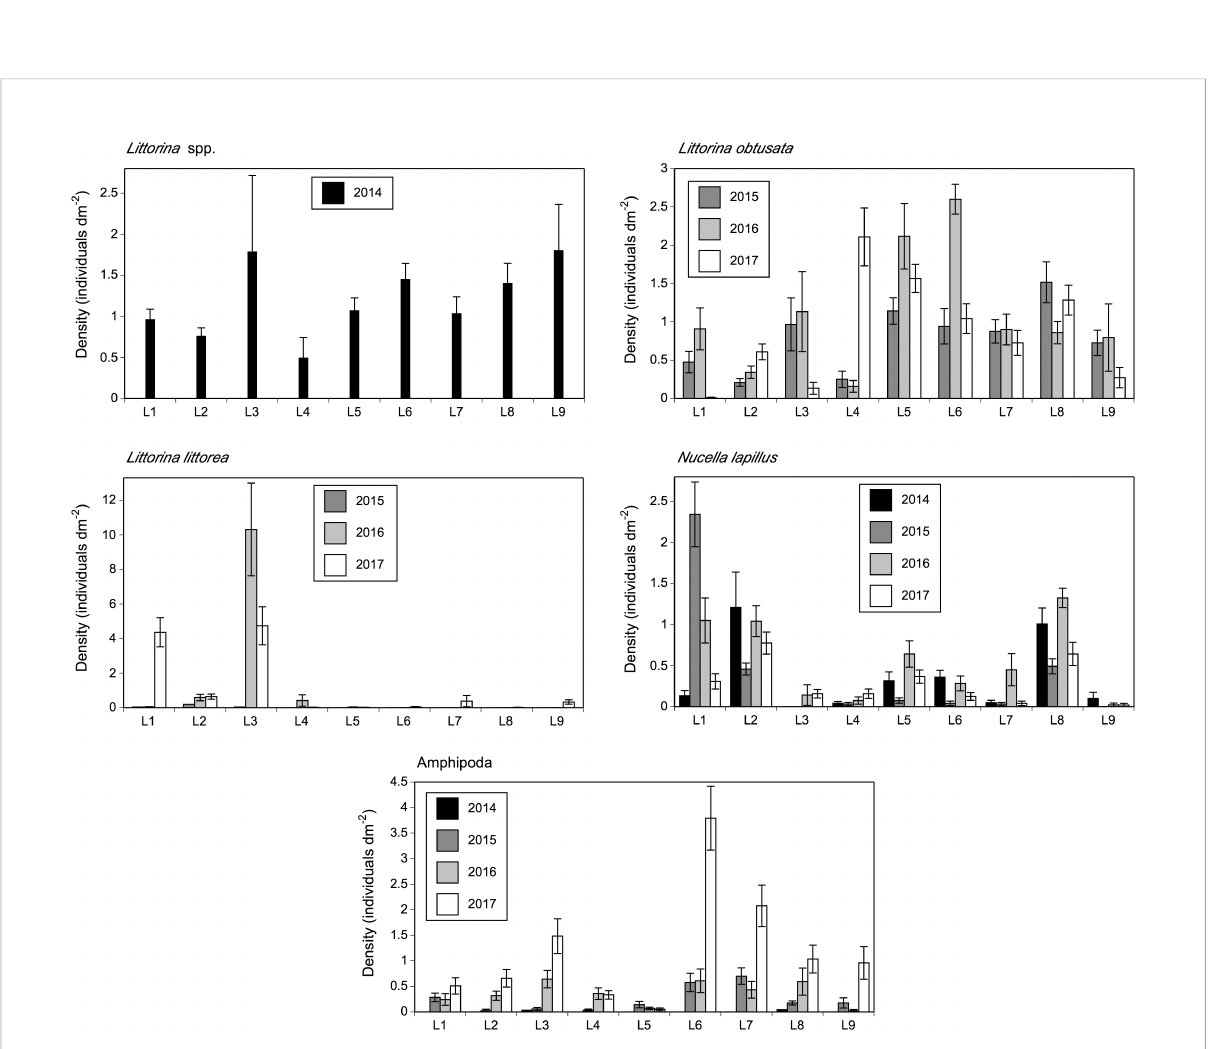
FIGURE 5 Density (mean ± SE) of the mobile species that had the largest contribution to the multivariate patterns for mobile species as revealed by SIMPER